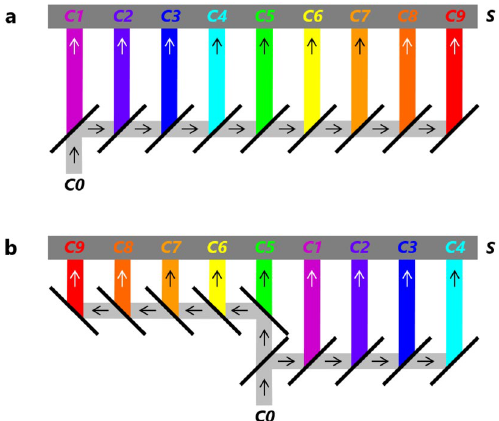
Figure 1. Schematic diagrams of conventional and novel nine-color spectrometers. ( a ) Conventional nine-color spectrometer with nine-dichroic-mirror array. ( b ) Novel nine-color spectrometer with two-layer biparted ten- dichroic-mirror array. Incident light flux C0 is split into nine color light fluxes C1 − C9 and detected by image sensor S